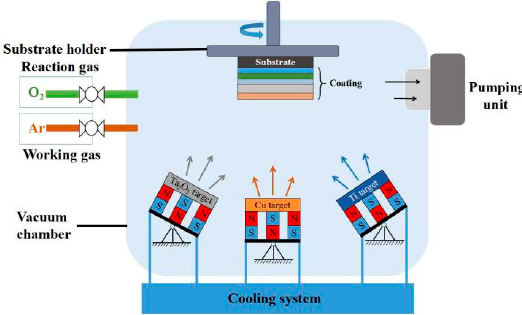
Figure 2. Schematic diagram of the magnetron sputtering system.